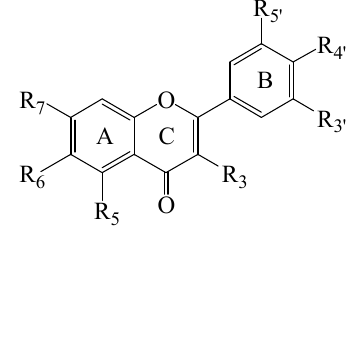
Figure 1. General structure of the investigated flavones and